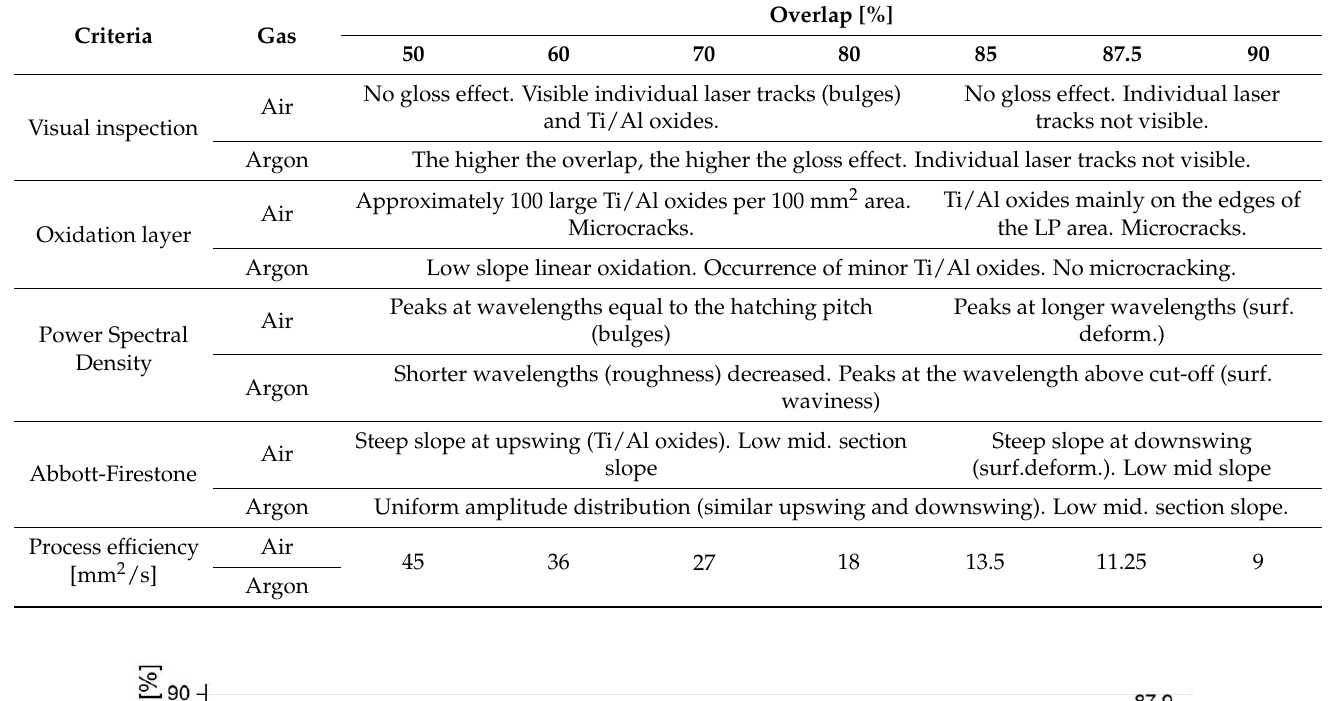
Table 3. Summary of the influence of overlap on surface features and process efficiency after applying Laser Polishing in the air and argon atmospheres.